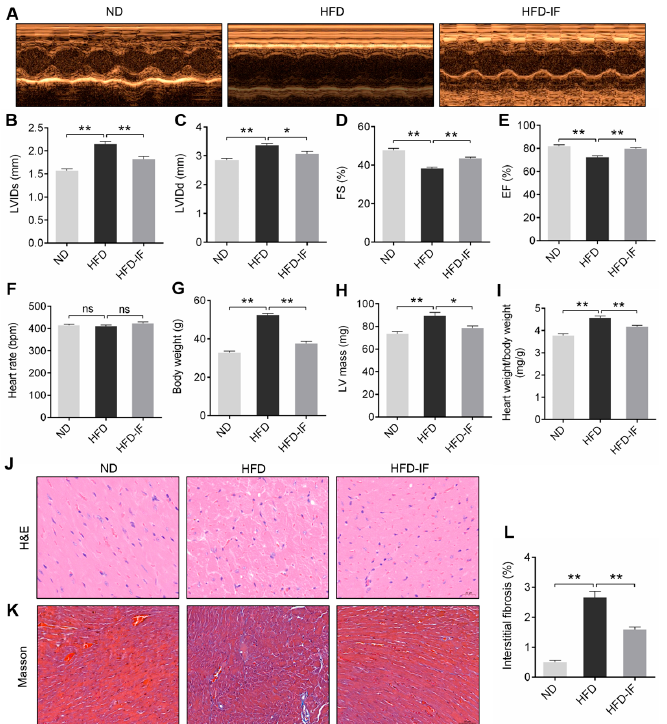
Figure 2. Effects of IF on myocardial structure and function in HFD-fed mice. ( A ) Echocardiographic measurements of ( B ) LVIDs, ( C ) LVIDd, ( D ) FS%, and ( E ) EF% for cardiac functional analysis. Measurements of ( F ) heart rate, ( G ) body weight, ( H ) LV mass, and ( I ) heart weight/body weight. Representative images of ( J ) H&E staining (scale bar = 20 µ m) and ( K ) Masson staining (scale bar = 50 µ m) cardiac sections. ( L ) Quantitative analysis of interstitial fibrosis. Data are shown as means ± SEM. * p < 0.05, ** p < 0.01. ns: no significant